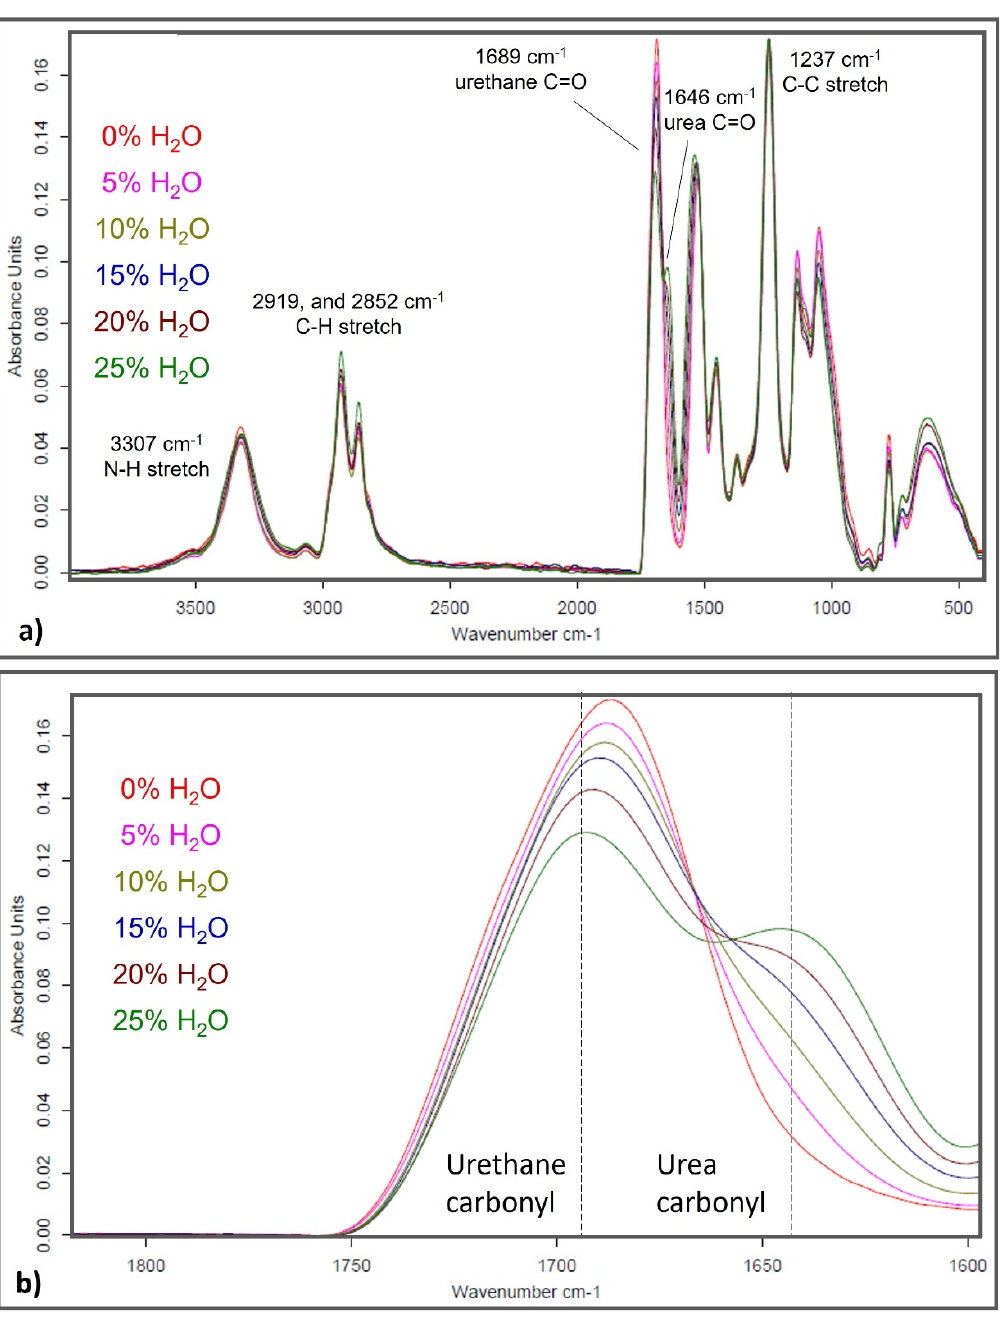
Figure 2. ( a ) Full absorbance spectra of SMP foams with varying water content. ( b ) Zoomed in spectra of SMP foams around 1600–1800 wavenumber (cm − 1 ) to show varying urethane and urea peak intensities as influenced by water content.